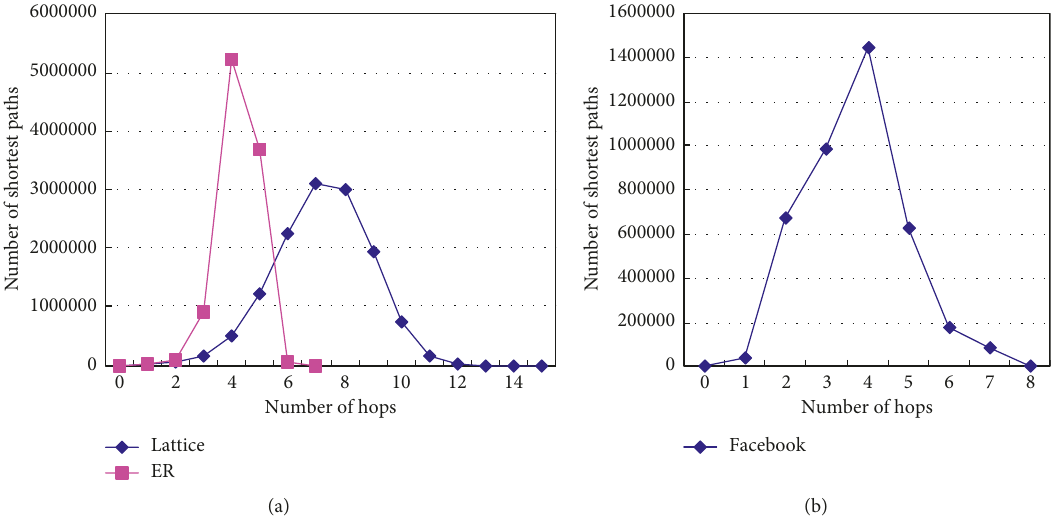
Figure 8: Average path length of three kinds of network structures. (a) Lattice and ER. (b)